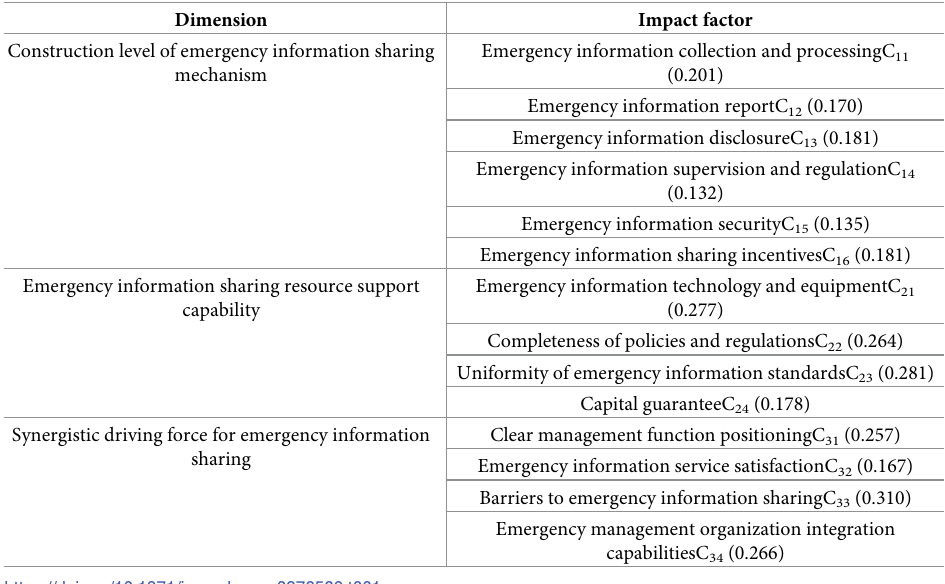
Table 1. Coastal city emergency information sharing collaborative efficiency measurement